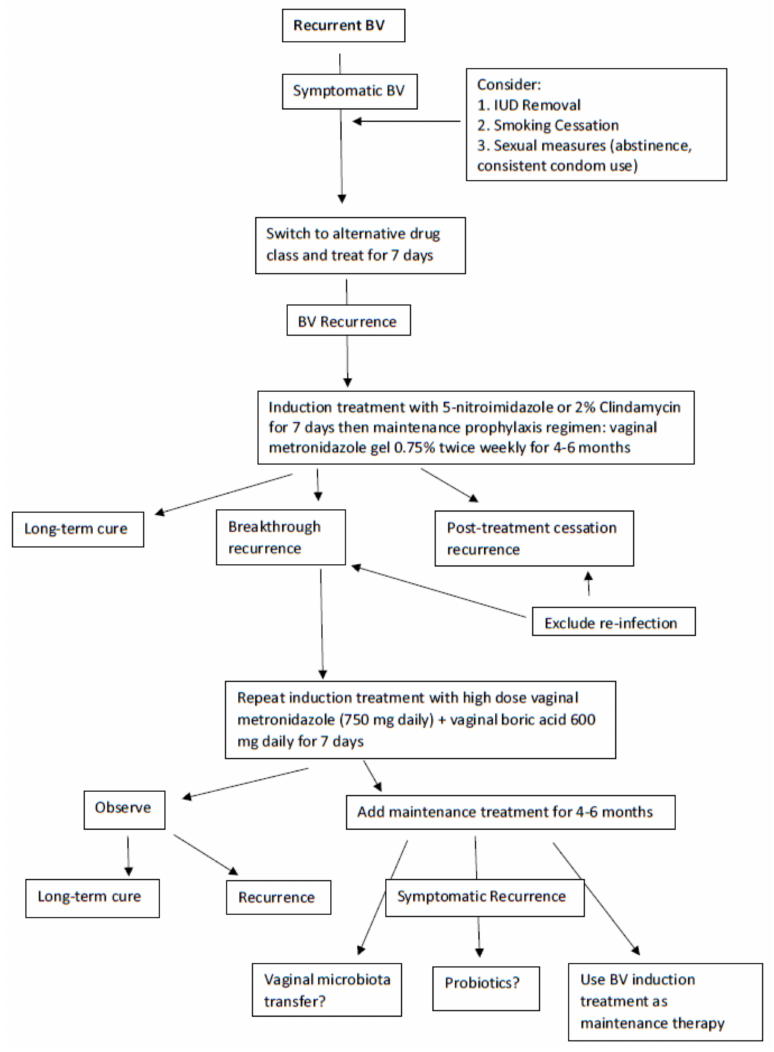
Figure 2. Recommended treatment algorithm for recurrent